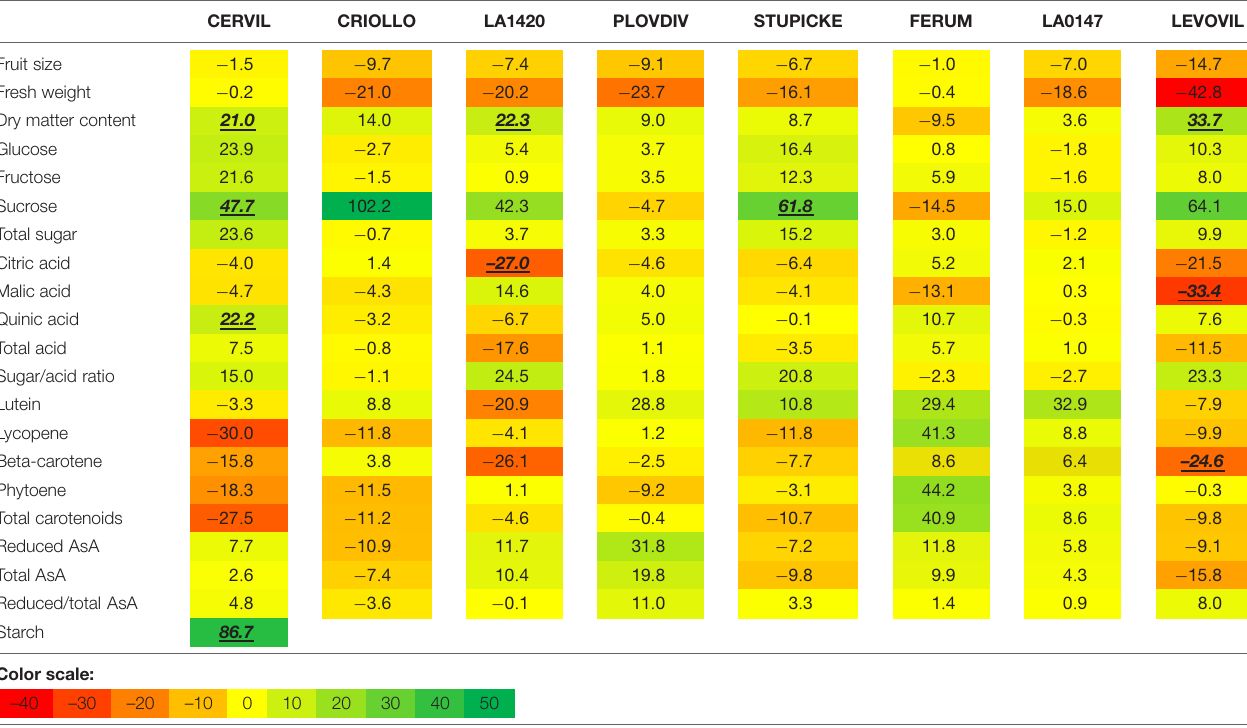
TABLE 4 | Relative differences in fruit metabolite contents between the WD treatments and the